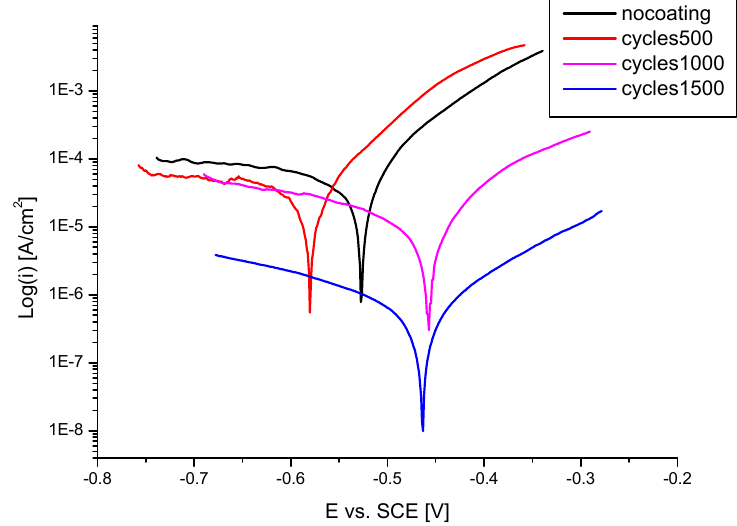
Figure 10. Variation of the open-circuit potential with time in the 3.5% NaCl solution at 25 °C.